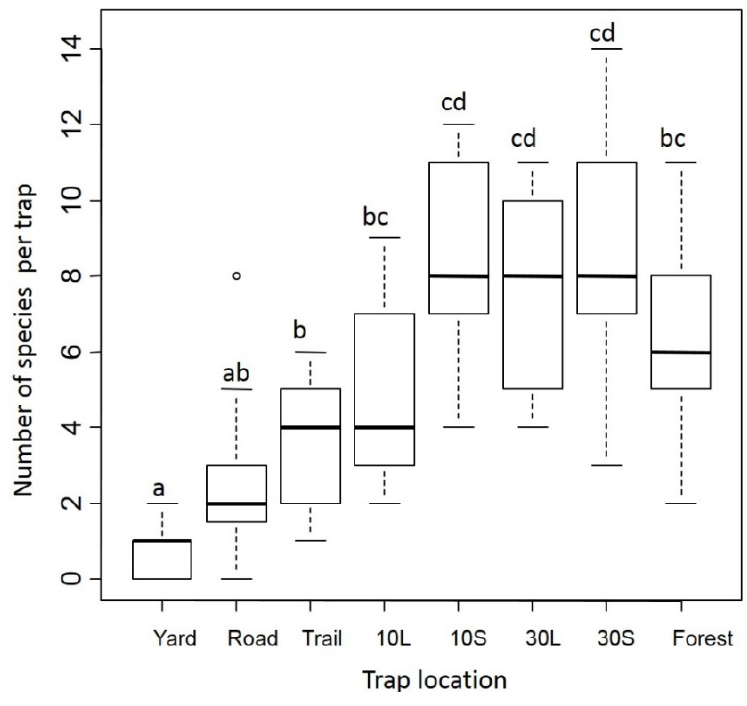
Figure 4. Number of dung beetle species collected with baited pit-fall traps; Yard, log yards; Road, logging roads; Trail, skid trails; 10 L, 30 L, 10 S, 30 S and Forest represent forests at 10 m or 30 m from logging roads, forest at 10 m or 30 m from skid trails and forests at 60 m from logging roads or skid trails, respectively. Data are shown with a median value (thick black line), 25th and 75th percentiles (upper and lower boundary of box) and maximum and minimum values (whiskers). Boxes labeled with different letters differ significantly among sites ( p < 0.05, Pairwise Wilcoxon Test with Holm